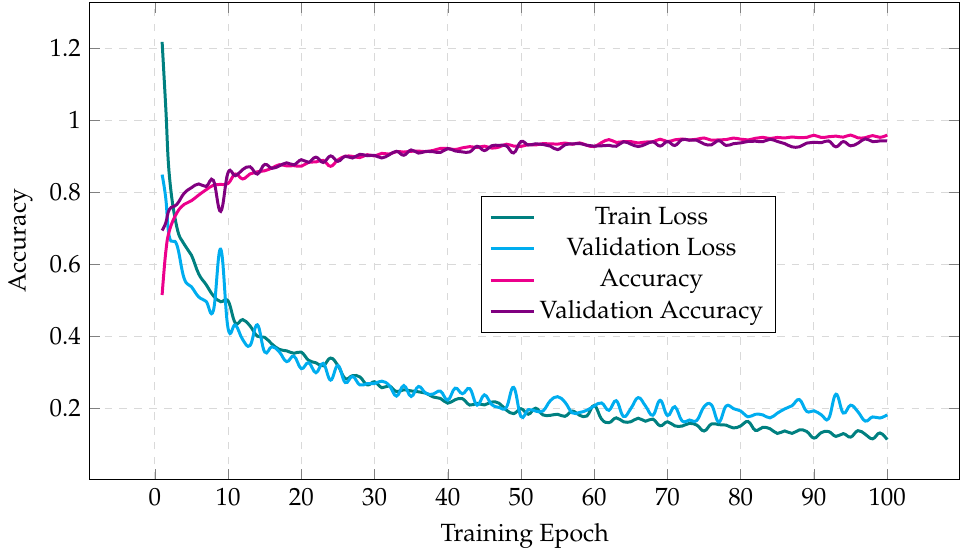
Figure 6. CNN model results trained on 4700